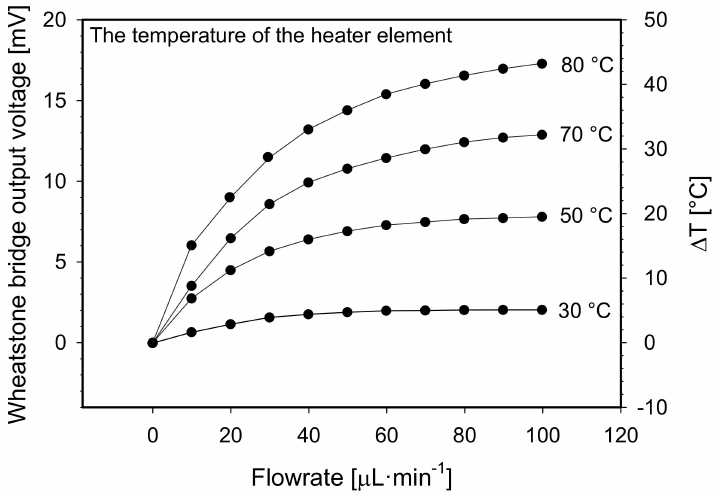
Figure 11. A constant temperature S-H-S flowmeter configuration: Simulated Wheatstone bridge output voltage and differential temperature between both sensor elements vs. flowrate for preselected heater temperature